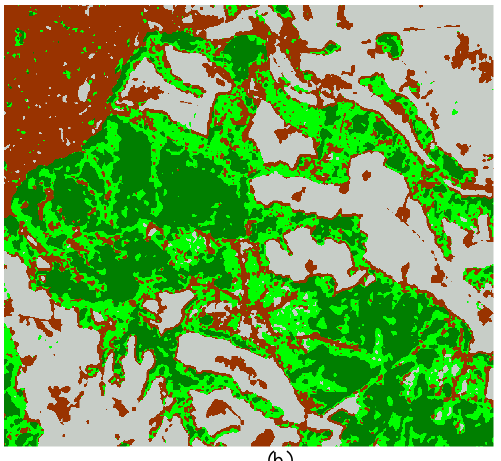
Figure 4. Comparison of the original classification map (a) and the refined classification results (b). (Red: buildings; Grey: ground; Dark green: high forest; Light green: low forest).